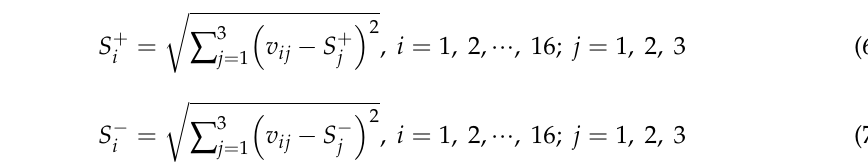
and S − and the closeness of each i i are also listed in Table 4. It can be i